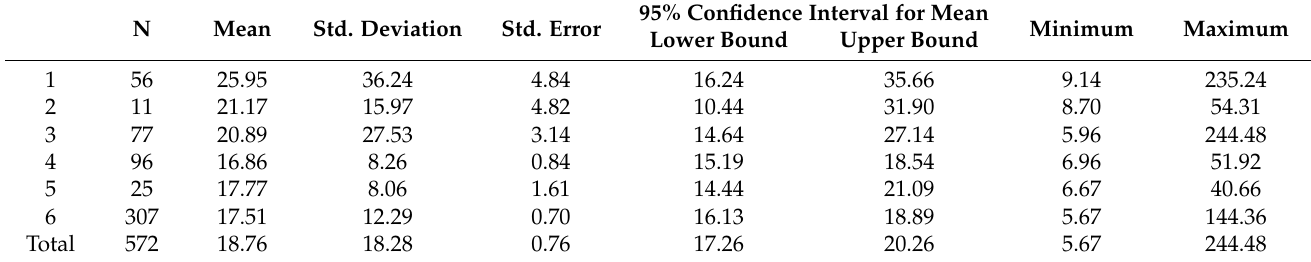
Table 5. Bottled wine prices for six brand identity clusters.